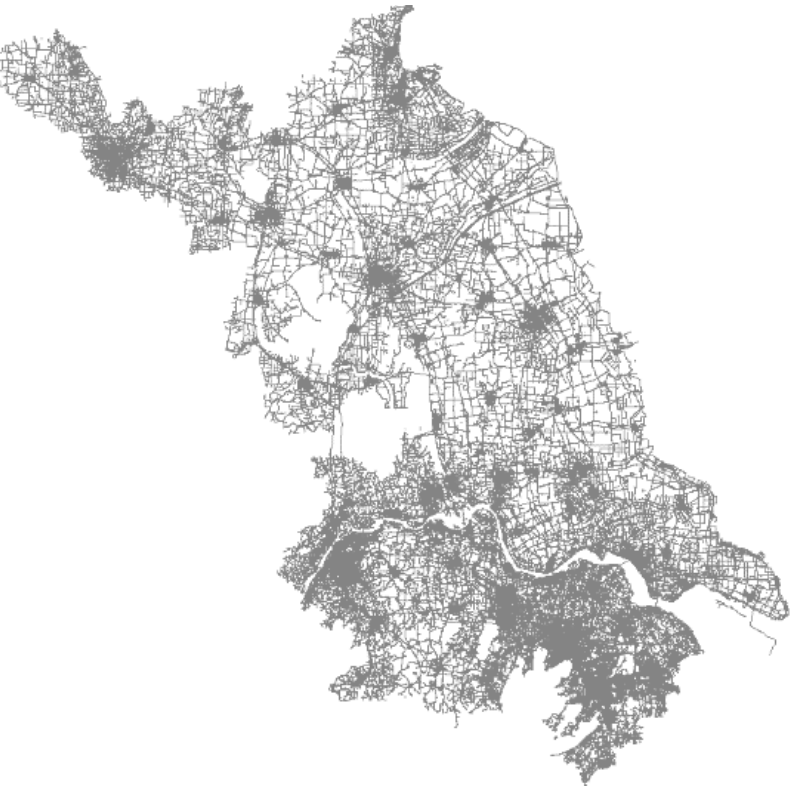
Figure 7. Moving objects in the road network.